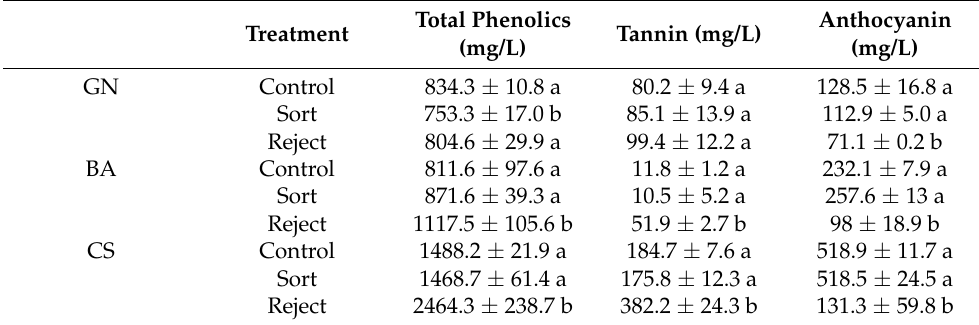
Table 6. Means and standard deviations for total phenolics, tannin, and anthocyanin (mg/L) in finished wines determined by the Adams-Harbertson